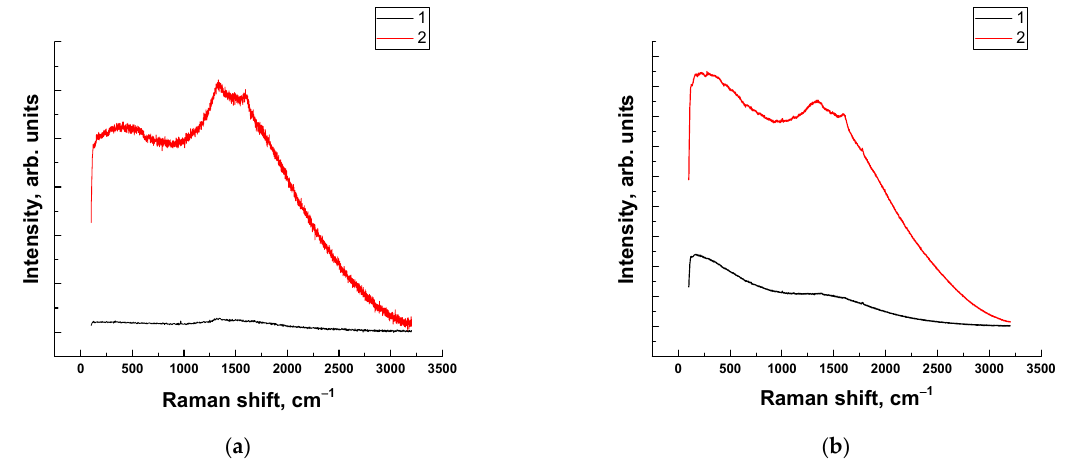
Figure 6. The Raman spectra on the steel counterpart ( a ) and the PEI/10CCF/1HNT nanocomposite ( b ): ( a ) outside (1) and inside (2) the TF; ( b ) outside (1) and inside (2) the TL. Table 4. The results of EDS analysis on the wear track surfaces shown in Figure